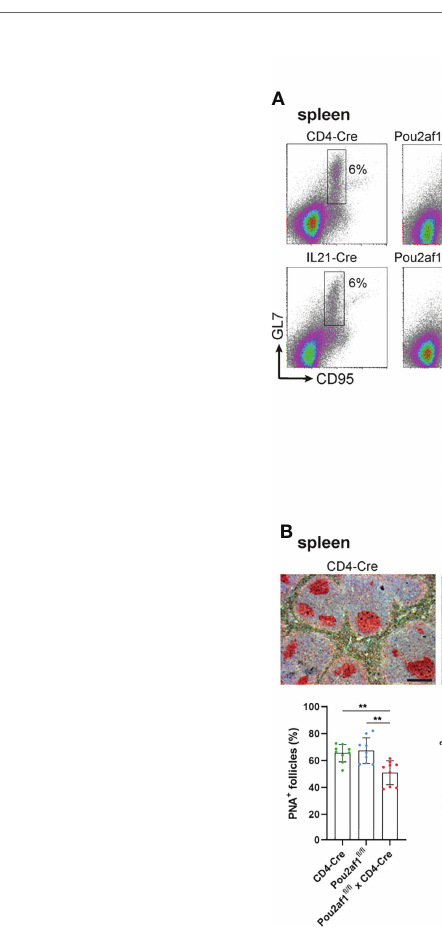
FIGURE 3 | CD4 + T- and TFH cell-speci fi c BOB.1/OBF.1 expression is required for ef fi cient GC formation. (A) Representative fl ow cytometry plots and statistical analyses of GC B (GL7 + CD95 + ) cell numbers in spleen and LN are shown. Gating strategy is shown in Figure S9. (B) Representative immunohistochemical stainings of PNA + GCs for each genotype and respective Cre-controls are shown. Scale bars indicate 200 µm. Statistical analyses showing PNA + GCs and GC size stained by immunohistochemistry. Each point represents data from a single mouse. Data in the graphs are shown as means ± SD (n= 9 mice per group). Data are merged from two independent experiments. *p < 0.05, **p < 0.01, ***p < 0.001, and ****p < 0.0001. P-values were determined using a two-tailed Student ’ s t test or Mann-Whitney-U